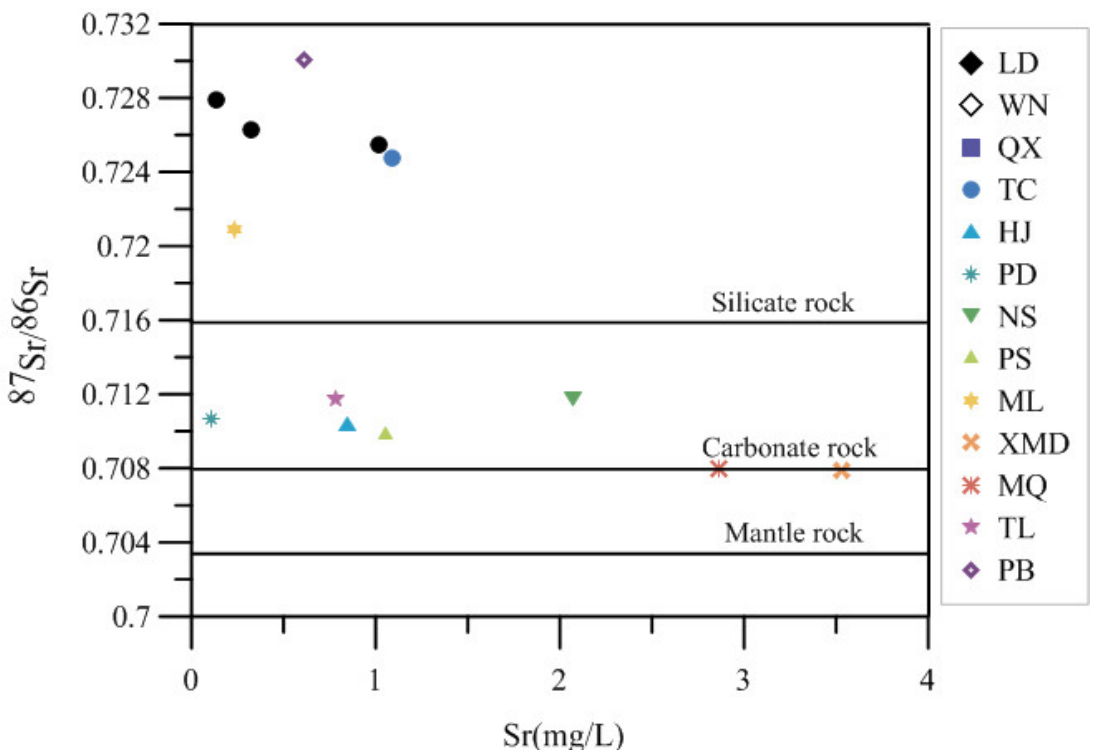
Figure 7. Trace element distribution, in terms of enrichment coefficient normalized to Ti, for the waters of the intersection of the RRF and the XJF.